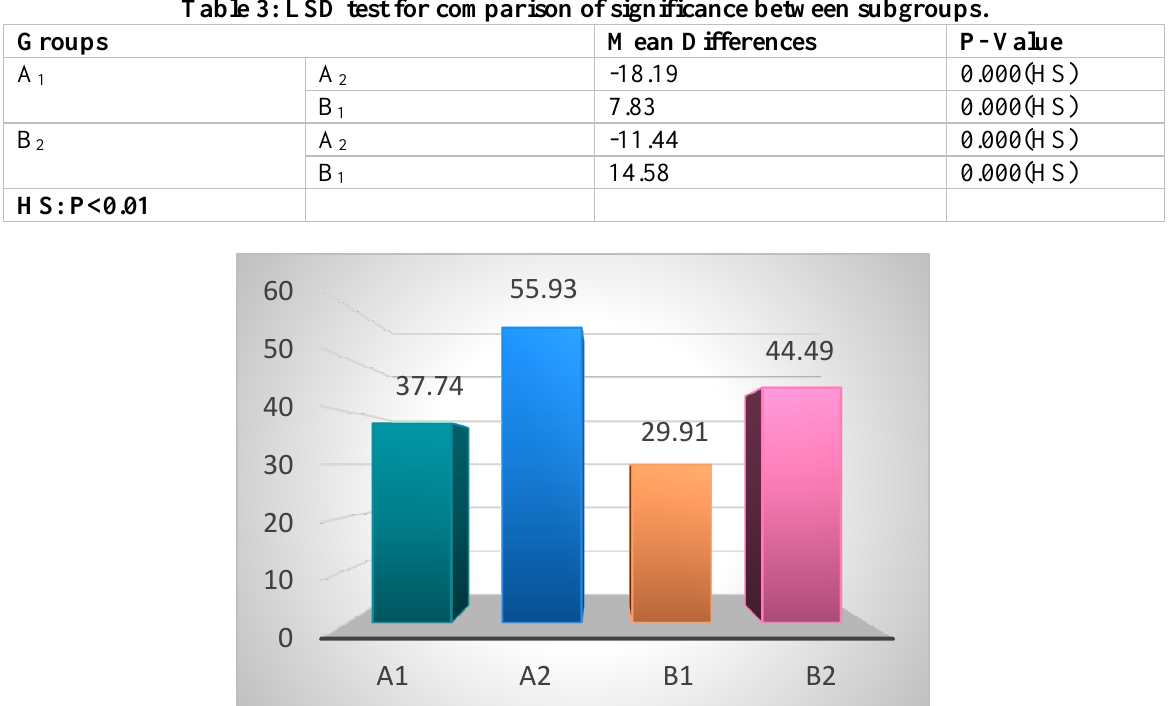
Figure 7: Bar-chart showing the mean values of the marginal gap in (μm) for all